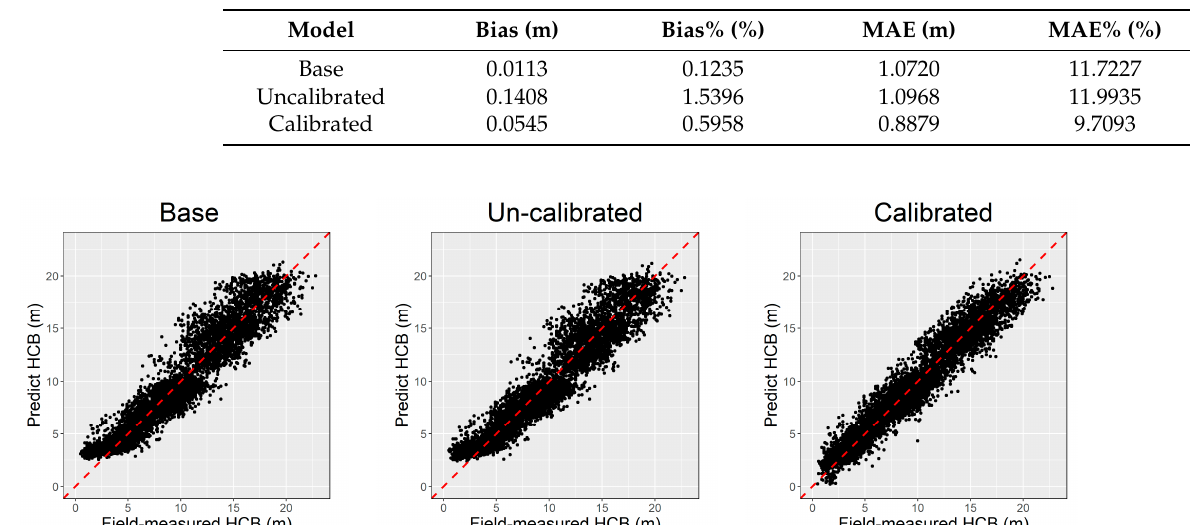
Figure 4. The predicted vs. field-measured height to crown base (HCB) calculated by different models.